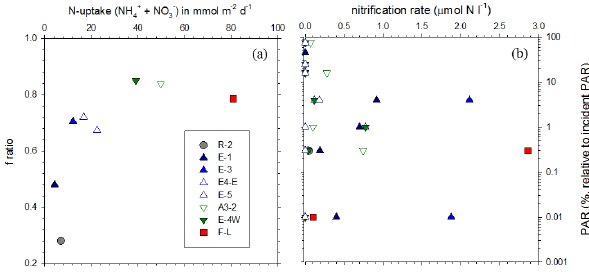
Figure 5. Relationship between mixed layer depth integrated N up- + NO − ) and f ratio (a) and between PAR (%) and take (NH + 4 3 nitrification rates (b)